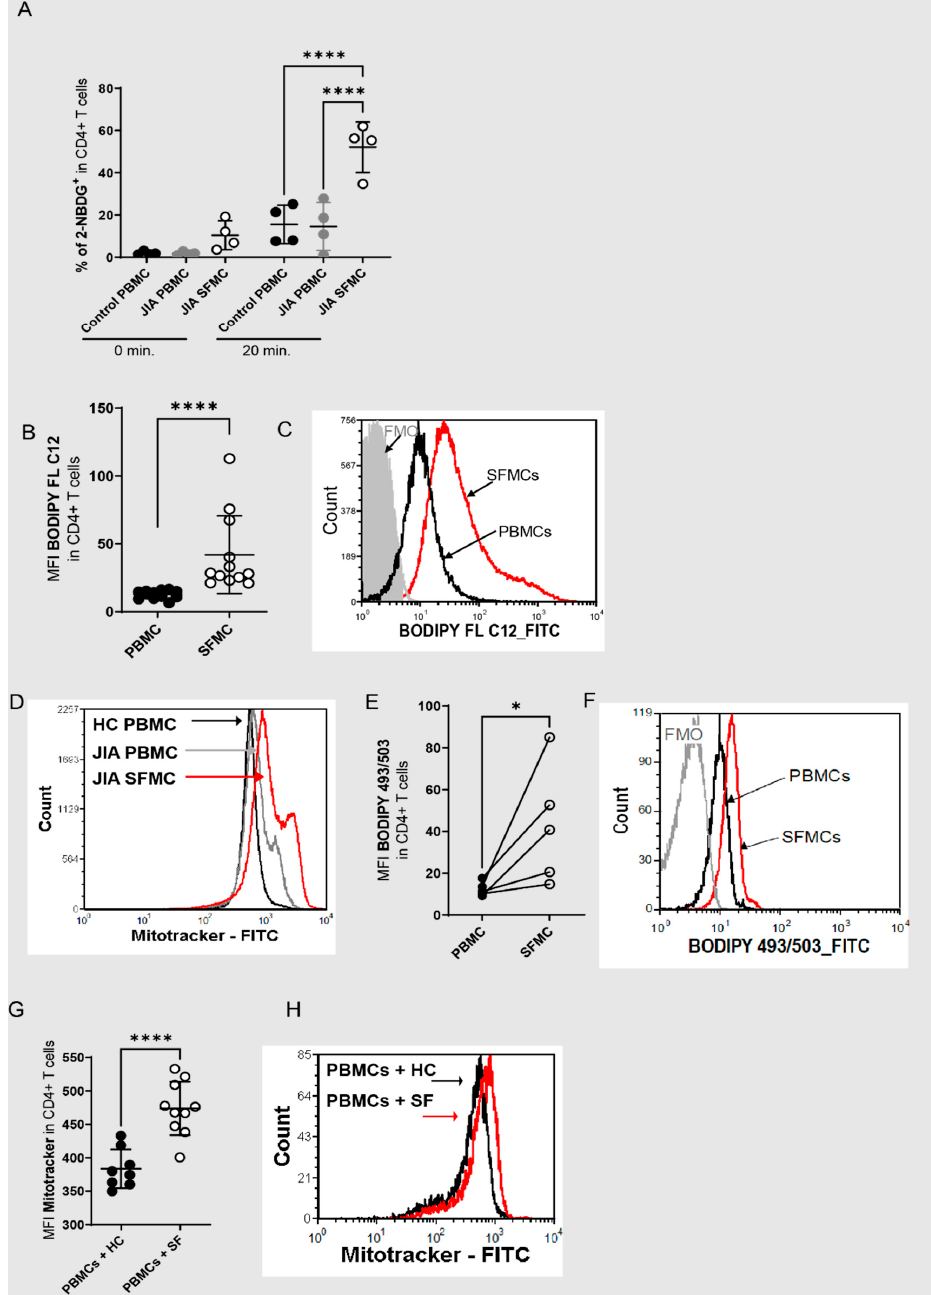
Figure 1. Redox metabolism is dysregulated in T cells within inflamed joints. ( A ) 2-NBDG incorporation was analyzed in CD4+ T cells from healthy control PBMCs (HC PBMCs), JIA PBMCs and SFMCs from the inflamed joints of JIA patients (JIA SFMCs) at different time points (N = 4 for donors and four individual experiments), an ordinary one-way ANOVA Tukey’s multiple comparison test was performed. ( B ) Quantitative results of geometric mean fluorescent intensity (MFI) of BODIPY FL C12 (N = 12 for donors and 12 individual experiments) on JIA PBMCs and SFMCs, and a Mann–Whitney test was performed. ( C ) Representative histogram of the MFI of BODIPY FL C12 in CD4+ T cells from JIA PBMCs (black) and SFMCs (red). ( D ) Representative histogram of the MFI of Mitotracker in CD4+ T cells from HC PBMCs (black), JIA PBMCs (grey) and SFMCs (red). ( E ) Lipid content in CD4+ PBMCs and SFMCs (N = 5 for donors and five individual experiments) measured as BODIPY